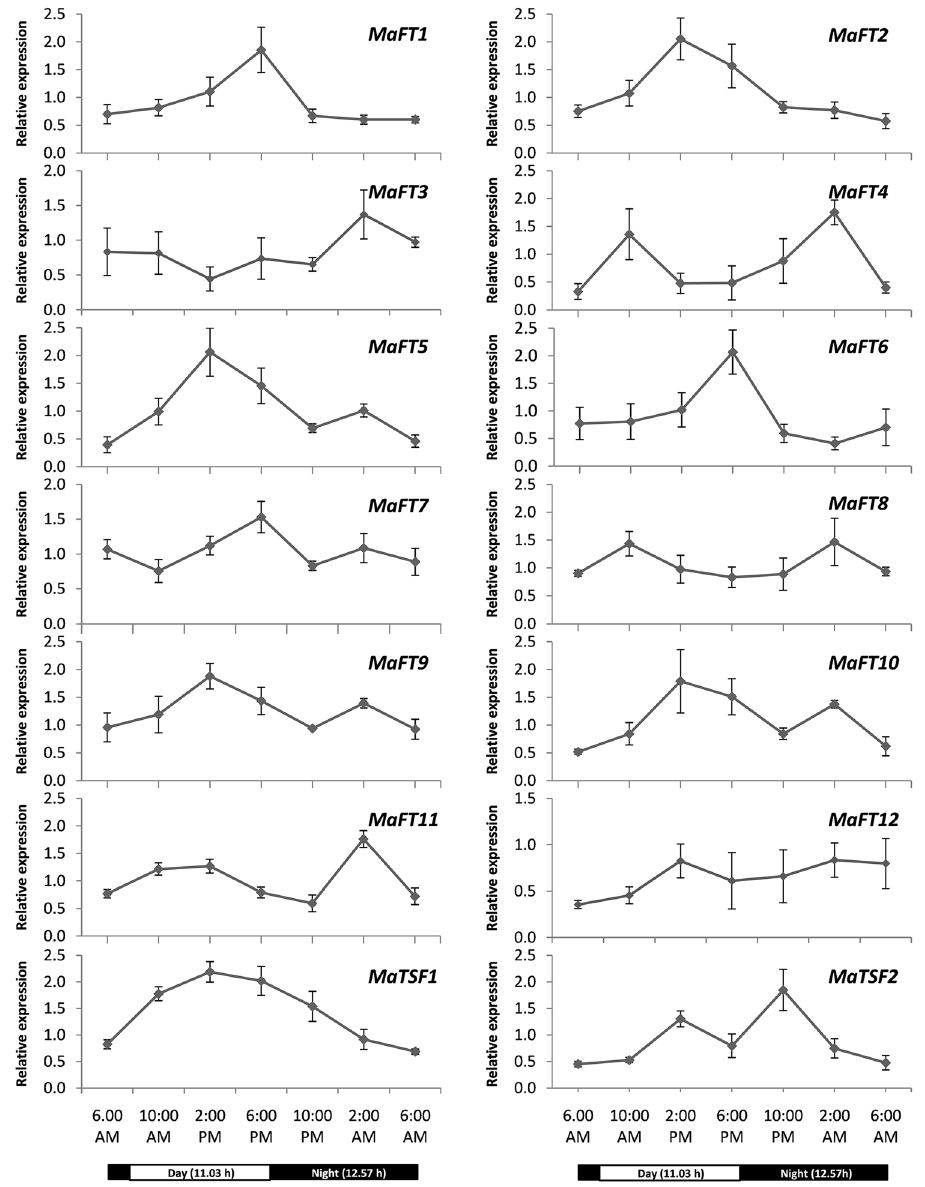
Figure 7. Diurnal expression patterns of FT / TSF -like genes of banana by qRT-PCR. Black and white bars at the bottom represent day and night periods. The relative expression was normalized against RPS2 . The values are means of three biological and three technical replicates ( ±